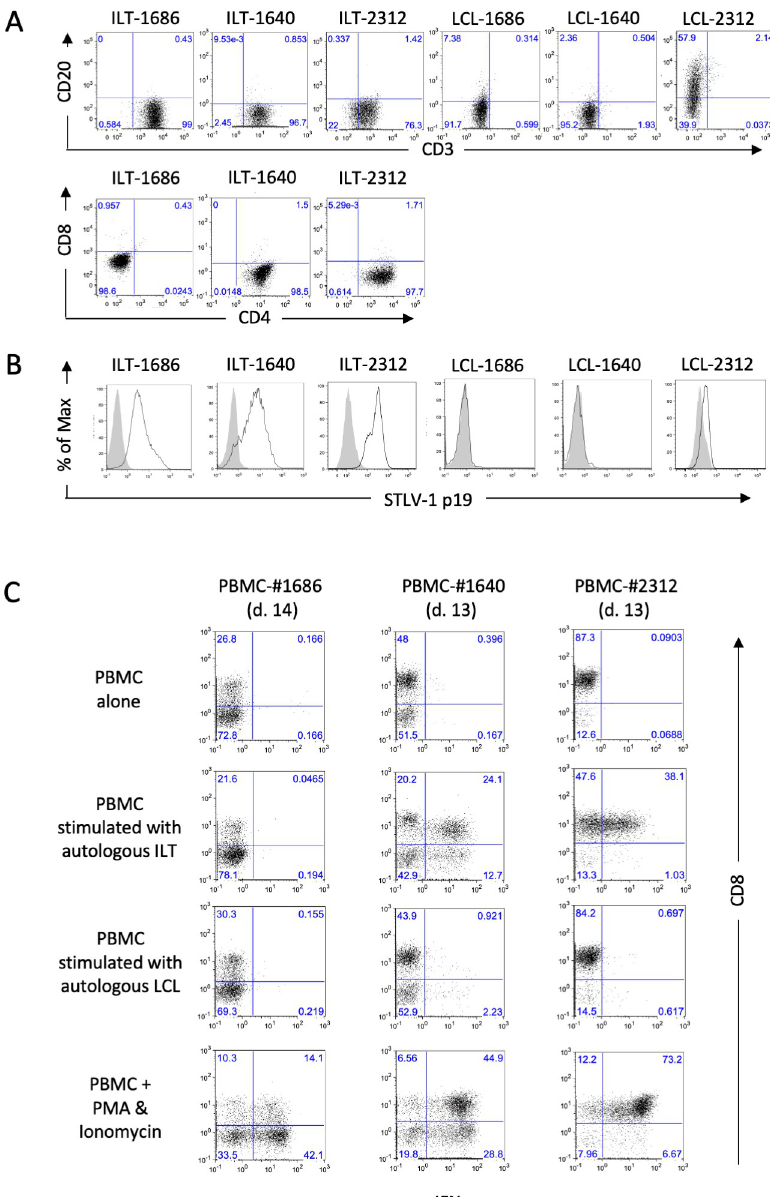
Fig 1. Detection of STLV-1-specific CTL responses in Japanese monkeys. Establishment of an evaluation system. A, B. Cell surface phenotype ( A ) and intracellular STLV-1 antigens ( B ) in representative STLV-1-infected T-cell lines (ILT-1686, ILT-1640, and ILT-2312) and herpesvirus papio-infected B cell lines (LCL-1686, LCL-1640, and LCL-2312) established from Japanese monkeys #1686, #1640, and #2312 were evaluated by flow cytometry as described in the Methods. In B , the open histogram indicates staining with anti-HTLV-1 p19 monoclonal antibody GIN7, which cross- reacts with STLV-1, and the closed histogram indicates the control staining with mouse IgG. C. PBMCs of monkeys #1686, #1640, and #2312 were co-cultured with formalin-fixed autologous ILT cells (ILT-1686, ILT-1640, and ILT- 2312, respectively) for 2 weeks in the presence of IL-2, and then stimulated again with or without autologous STLV- 1-infected cells or LCLs for 6 h in the presence of brefeldin A, prior to cytokine flow cytometry for intracellular IFN γ with surface CD8, CD3, CD4, CCR4, CD86, and HLA-DR. Cells stimulated with PMA and ionomycin served as positive controls. The strategy applied to gate out the stimulator cells is shown in S1 Fig. Neither STLV-1-infected cells nor LCL cells alone produced IFN γ .